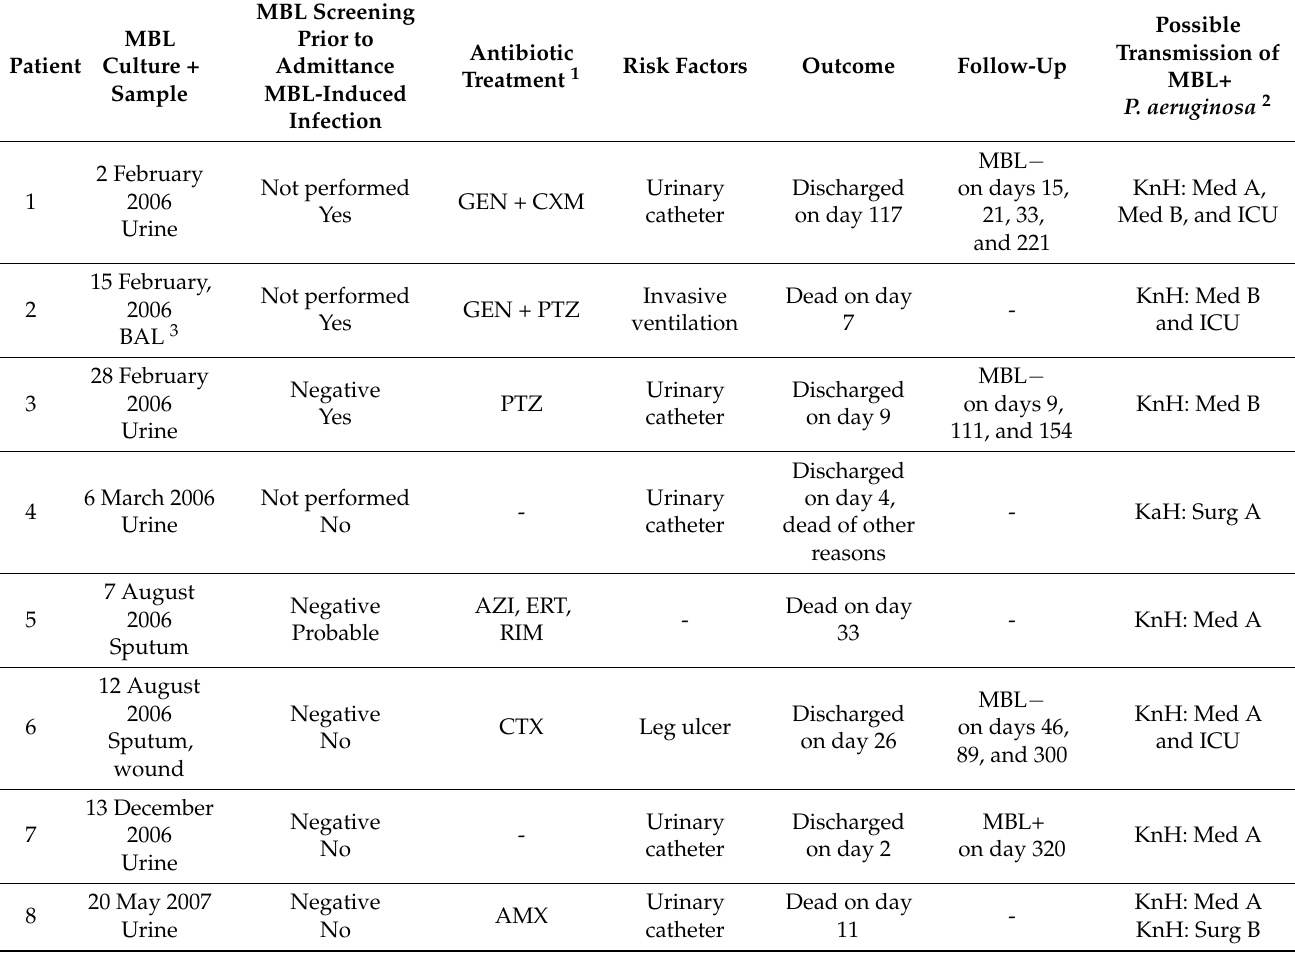
Table 1. Summary of the patient